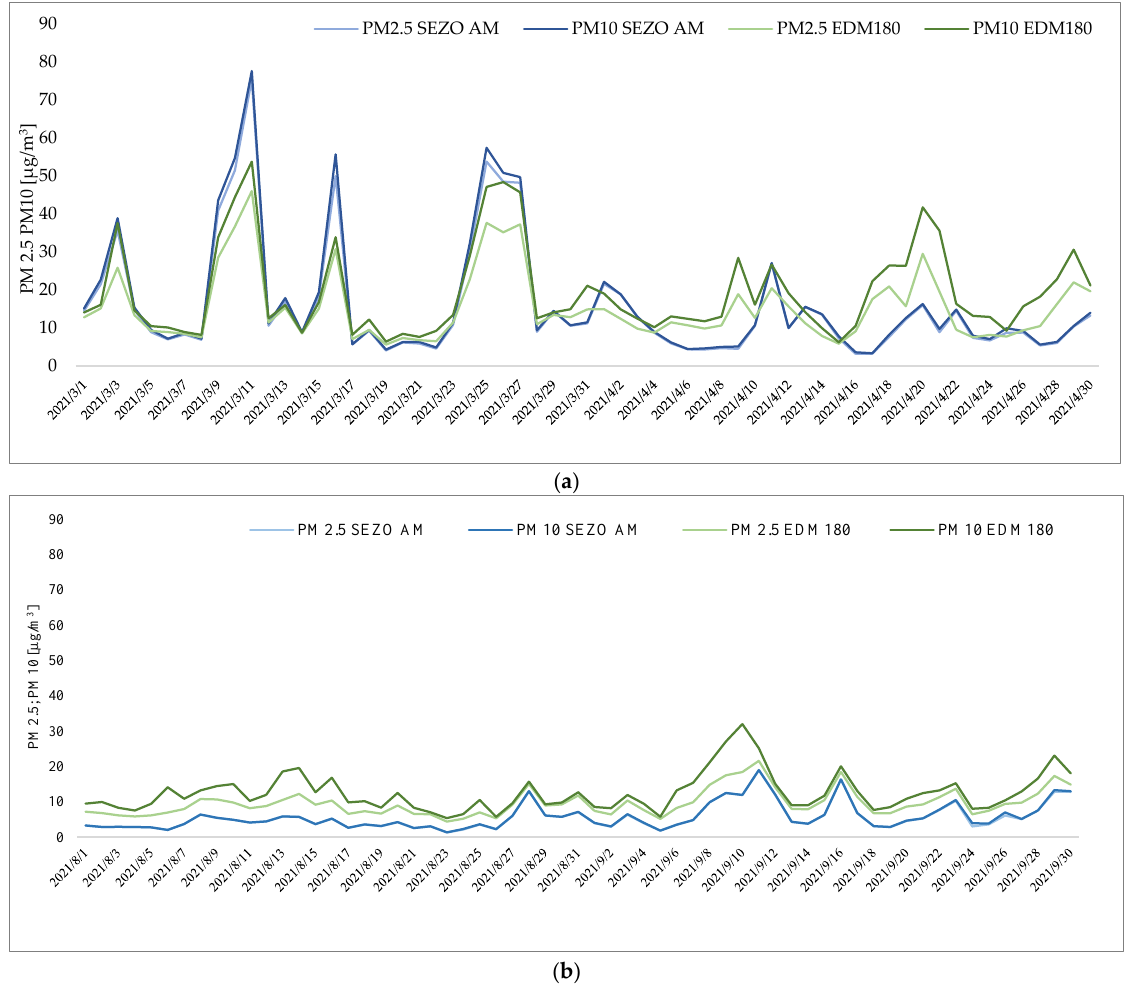
Figure 6. The variability of the daily concentration values of PM2.5 and PM10 in the period from 1 March to 30 April 2021 ( a ) and from 1 August to 30 September 2021 ( b ). The green colour represents the concentrations measured with the EDM 180 analyser, and the blue colour the concentrations obtained from the SEZO AM.